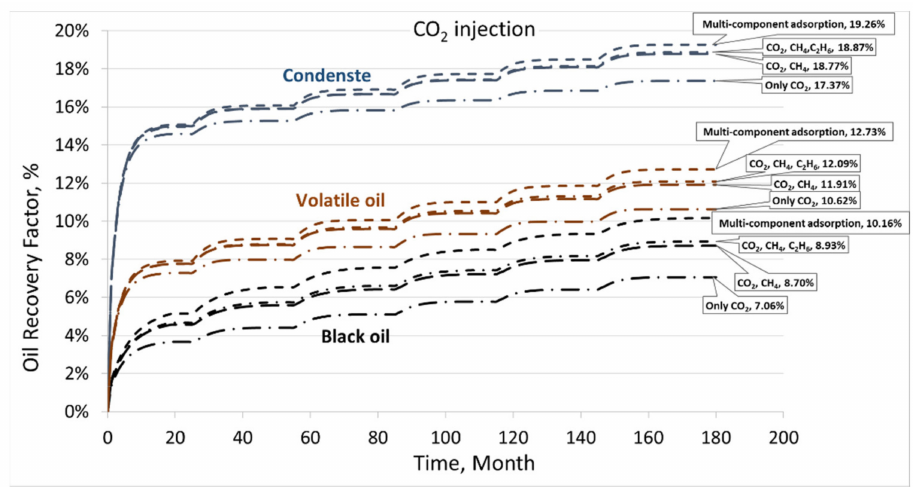
Figure 13. Impact of multicomponent adsorption on the production from different reservoir fluids.